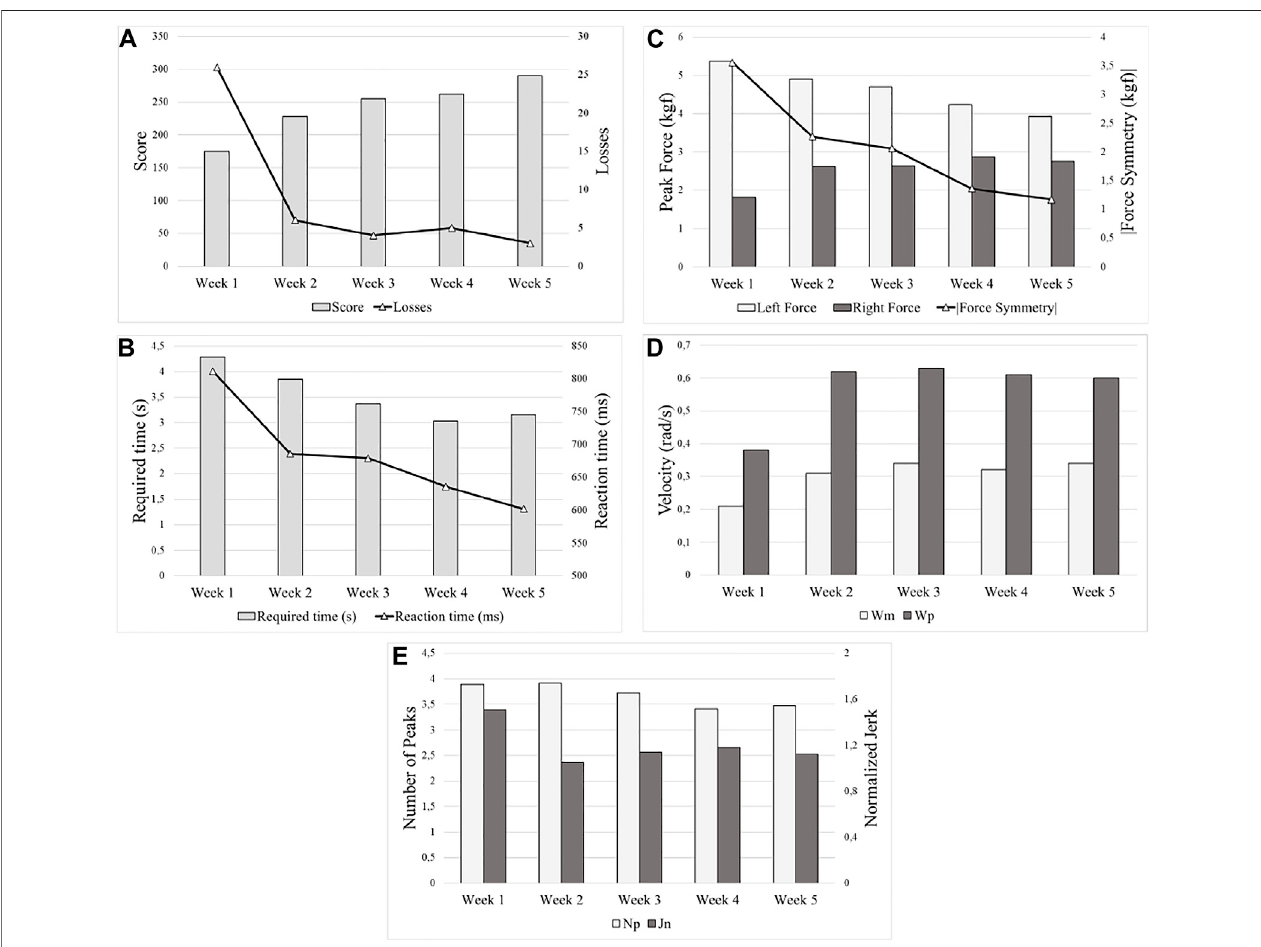
FIGURE14| Improvementovertime(weekbyweek)ofapost-strokesubjectunderthebimanualapproach, (A) scoreandlosses, (B) requiredandreactiontime T m and T r , (C) forces F p , F p , and δ F, (D) velocity ω m and ω p , and (E) movement smoothness parameters N p and J n . left right